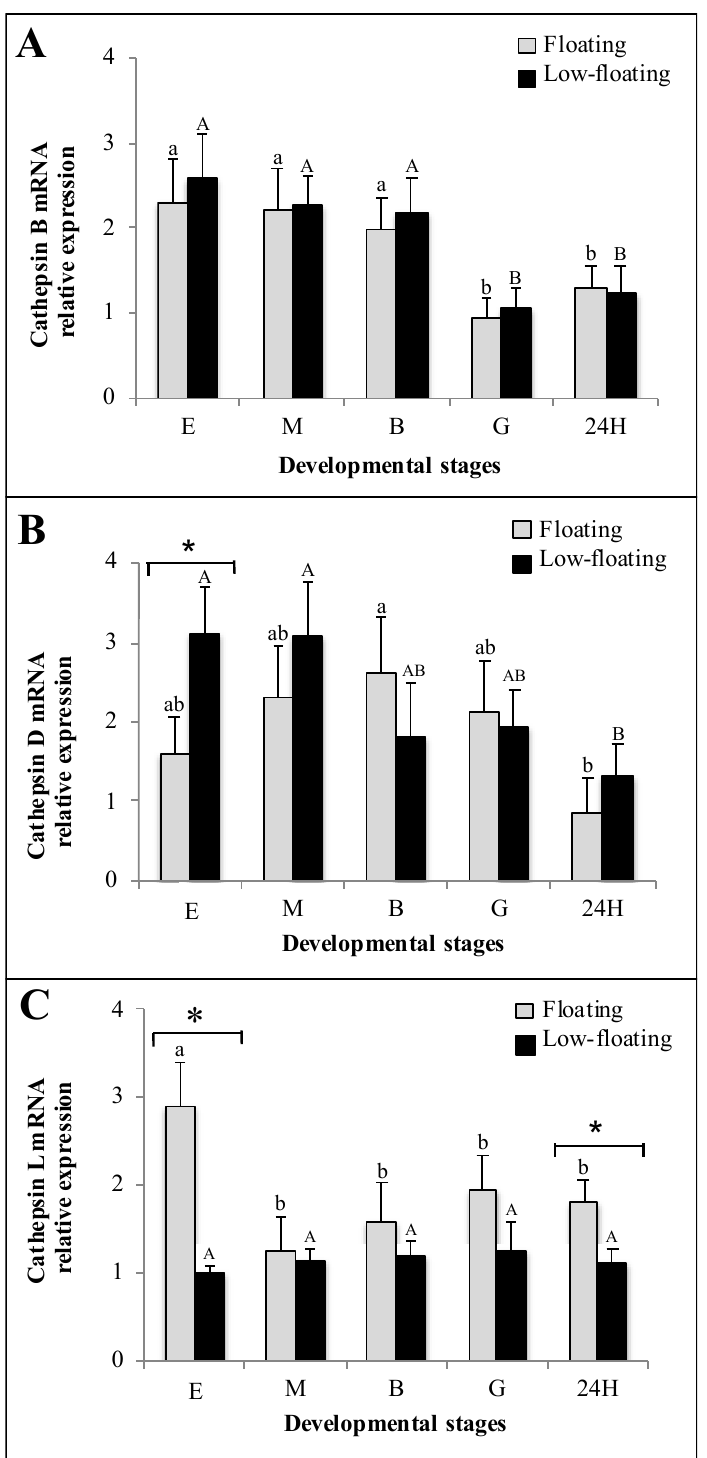
Figure 4. Relative expression of cathepsins B ( A ), D ( B ) and L ( C ), throughout Seriola lalandi devel- opment in floating (gray bars) and low-floating (black bars) embryos, assessed through RT-qPCR. Fertilized eggs, morula, blastula and 24 h post-fertilization embryos are identified as E, M, B, G and 24H, respectively. Bars represent mean ± standard deviation (SD) of six biologicals replicates, and different lowercase or uppercase letters indicate statistic differences within floating or low-floating embryos, respectively ( p < 0.05). Differences between floating and low-floating embryos are identified with an asterisk over a bracket.